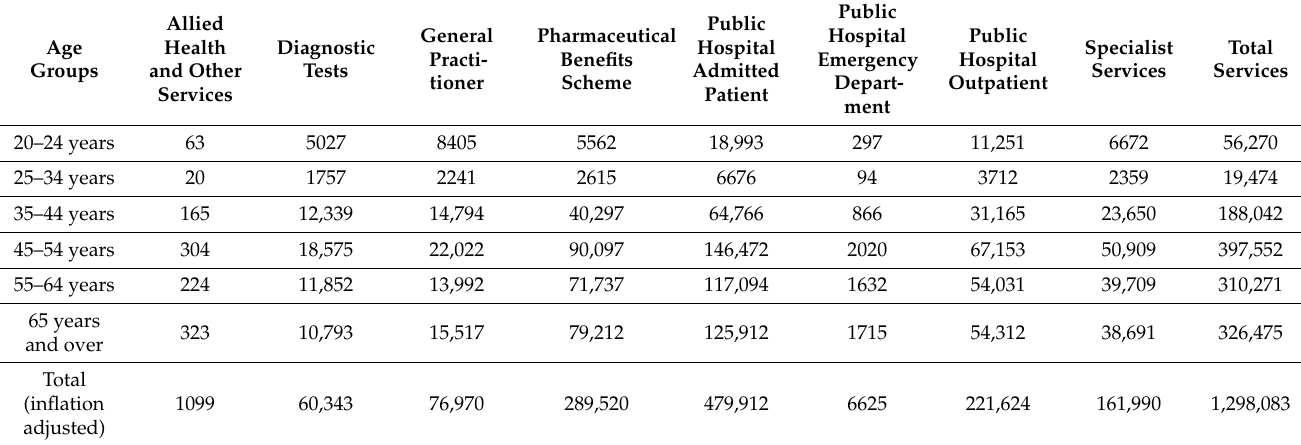
Table A4. Extra costs incurred due to Low HL for people diagnosed with Cancer in Blacktown LGA (Domain 6). Allied Age Health Groups